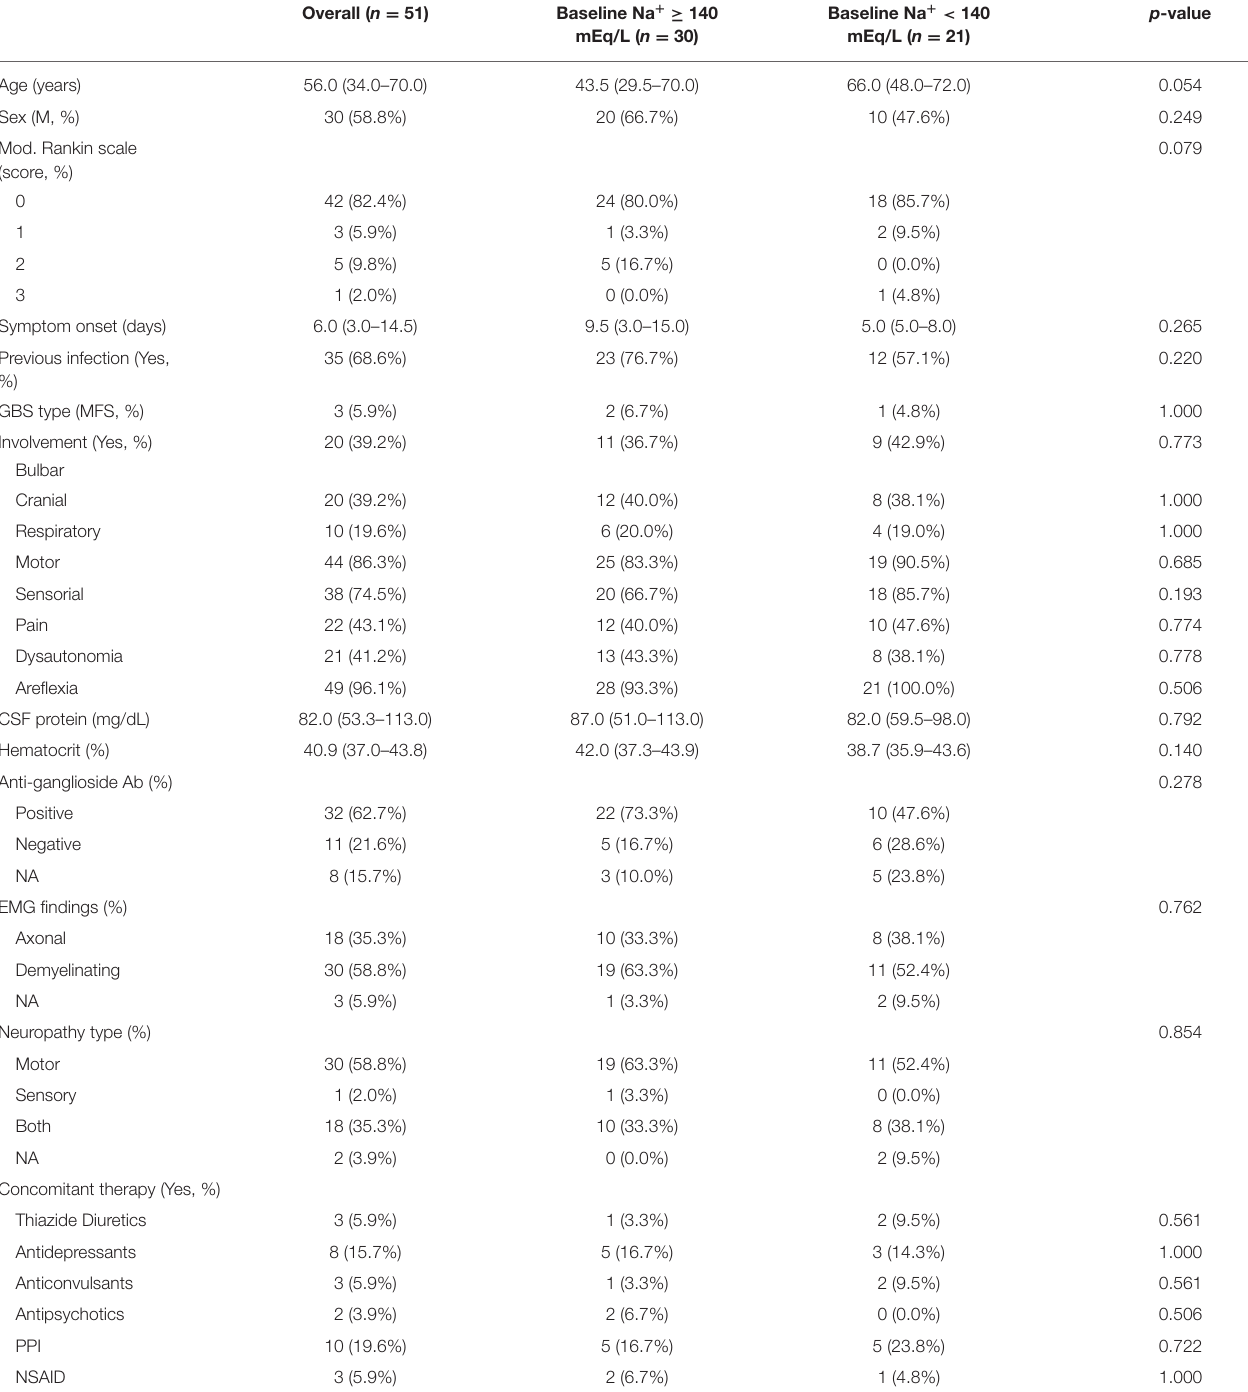
TABLE 1 | Baseline characteristics of 51 patients diagnosed with GBS at a single Italian